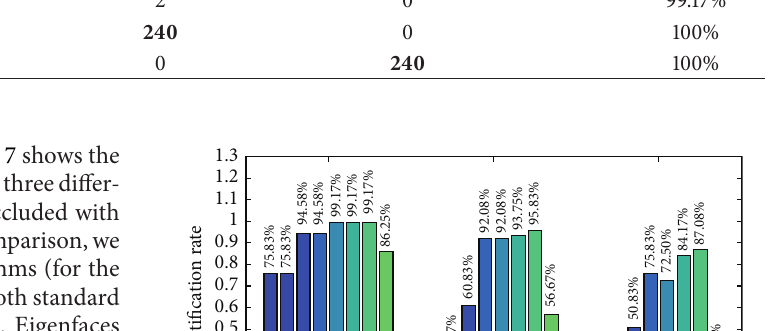
Clean Scarf Sunglasses